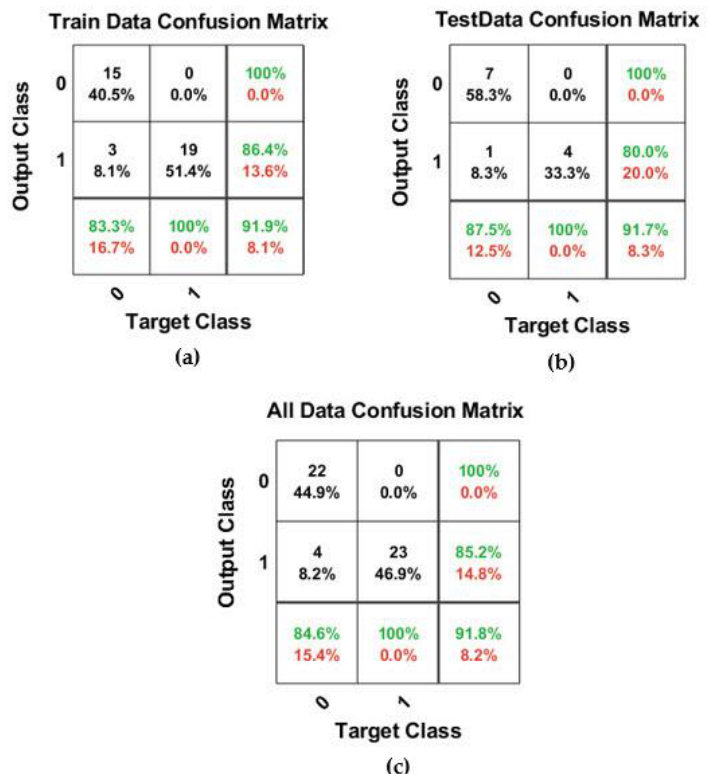
Figure 8. Results of the confusion matrix for training data ( a ), testing data ( b ), and total data ( c ) for k* = 1.8.